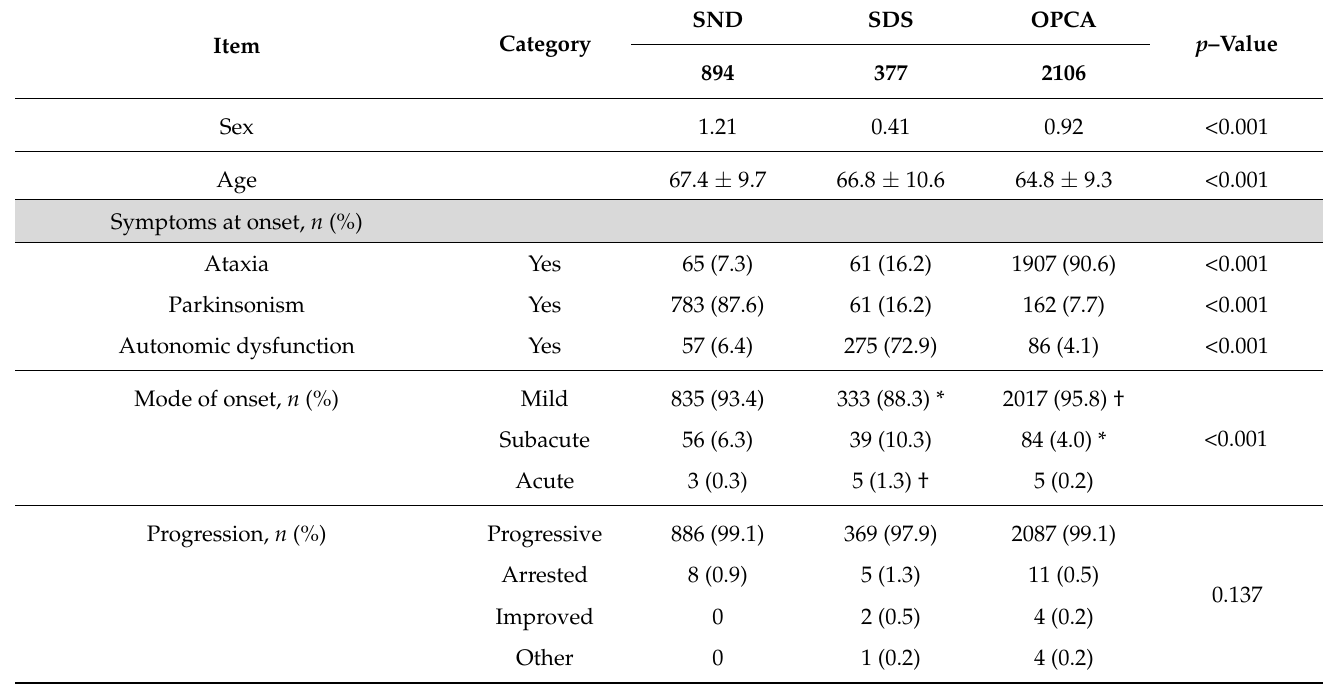
Table 4. Characteristics of MSA according to clinical